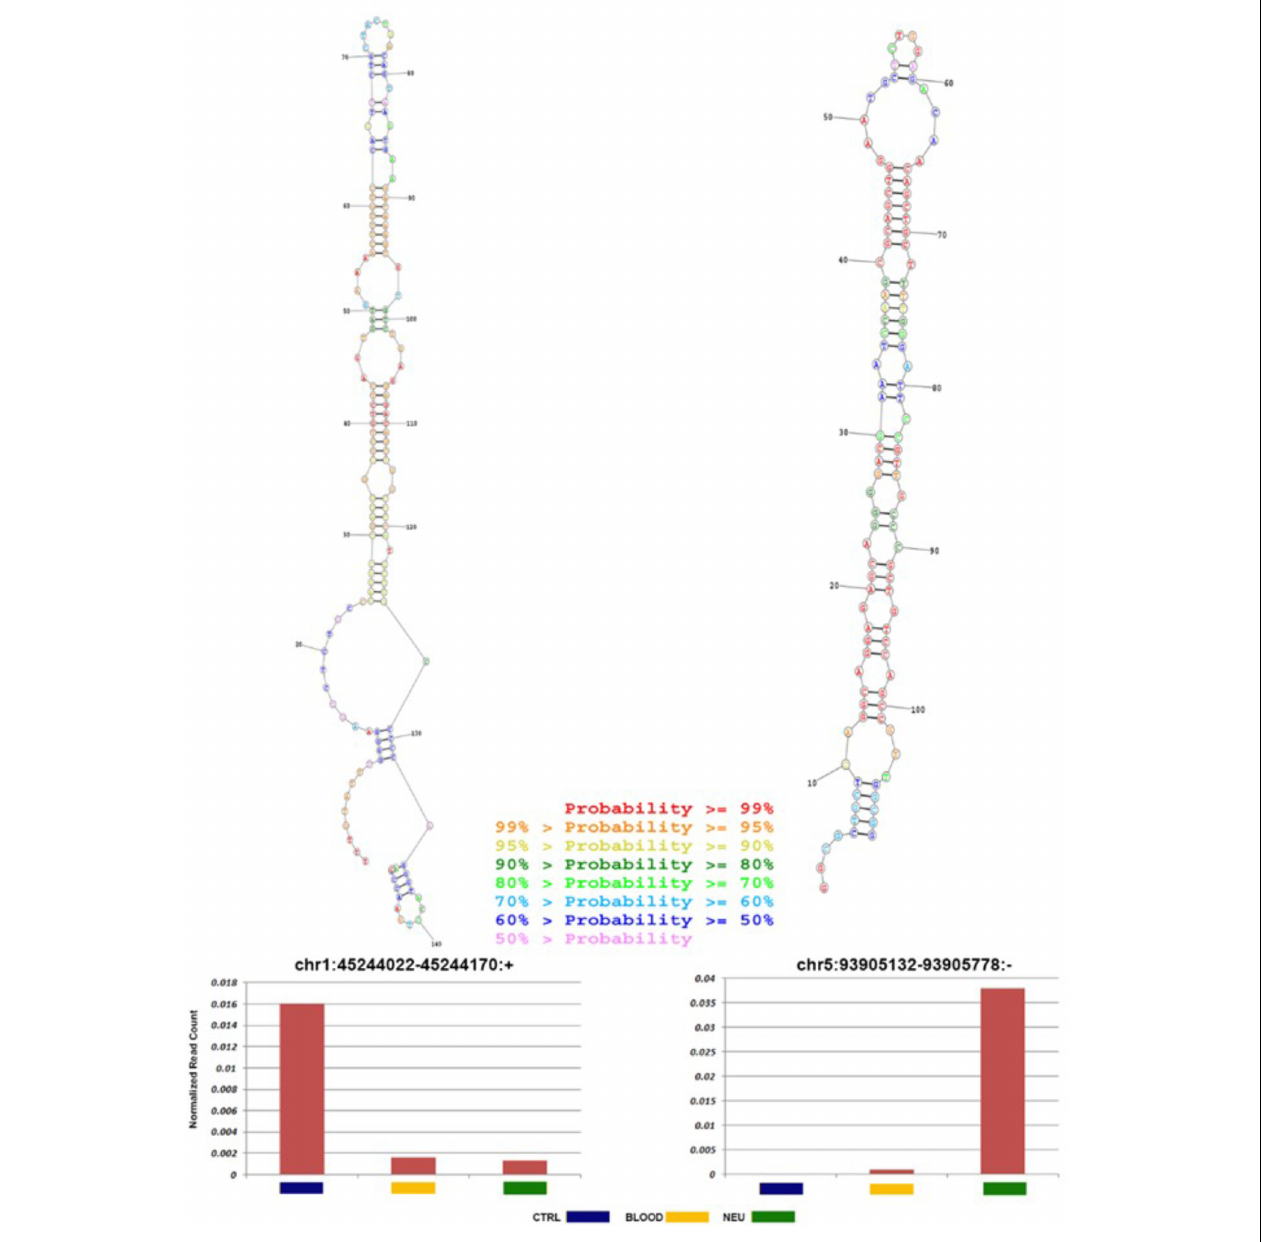
FIGURE 8 | Novel miRNA candidates discovered by next-generation sequencing. Number of reads found for each tissue type and secondary structures of the novel miRNAs. Histograms show the total number of reads sequenced for each sample (normal: blue; ALS blood: yellow; ALS neuromuscular junction: green) and for each portion of the miRNA identified (mature: blue; loop: red; and star: green). All novel miRNAs were computationally predicted to form stem-loop hairpin structures. Putative secondary structures for the two novel miRNAs discovered in this study are shown below the corresponding histograms. Red, yellow, blue, and purple indicate respectively the mature sequence, the loop structure, the predicted star sequence, and the star sequence when identified in our sequencing